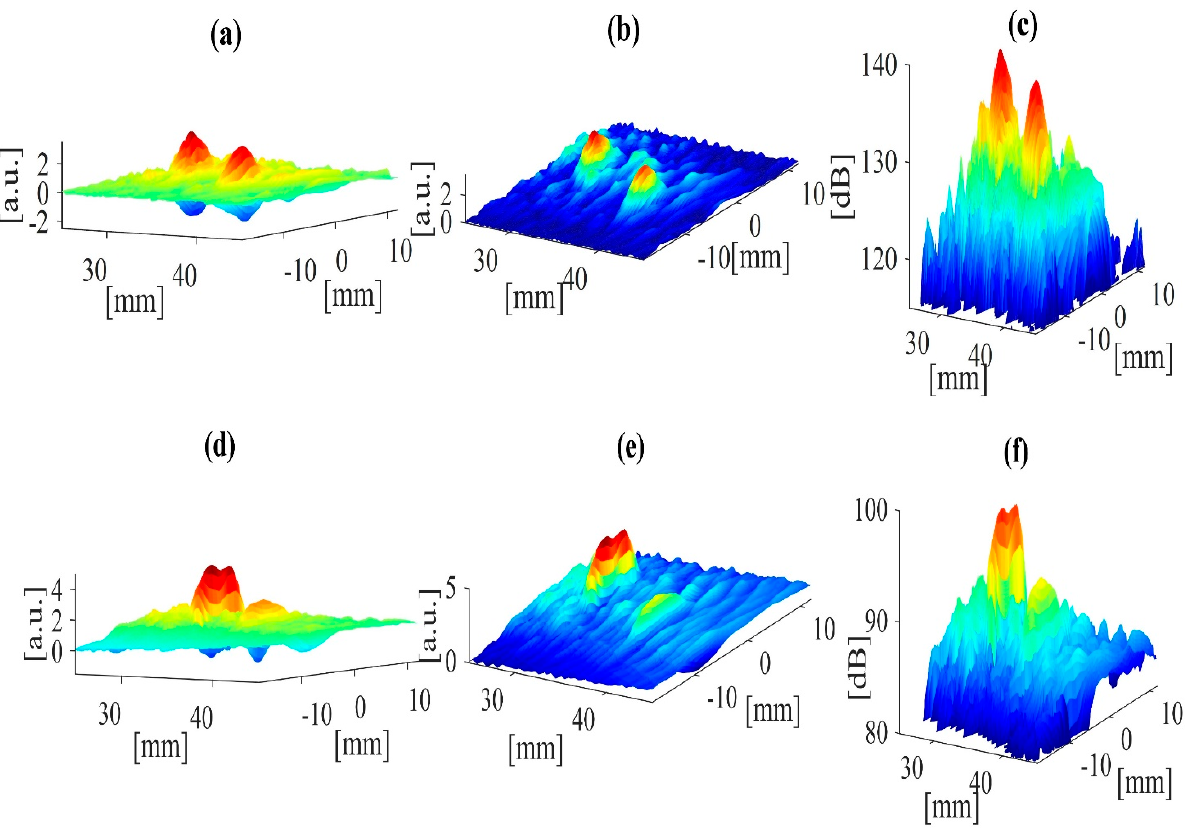
Figure 9. Surface image of the defects no. 3 and no. 4, highlighting the defect detection capability of the used methods. ( a – c ) are the 3D demonstration of the pulse-compression-based TFM images shown in Figure 7, while ( d – f ) are the 3D demonstration of the standard pulse-echo-based TFM images shown in Figure 8, at the location of defects no. 3 and no. 4.